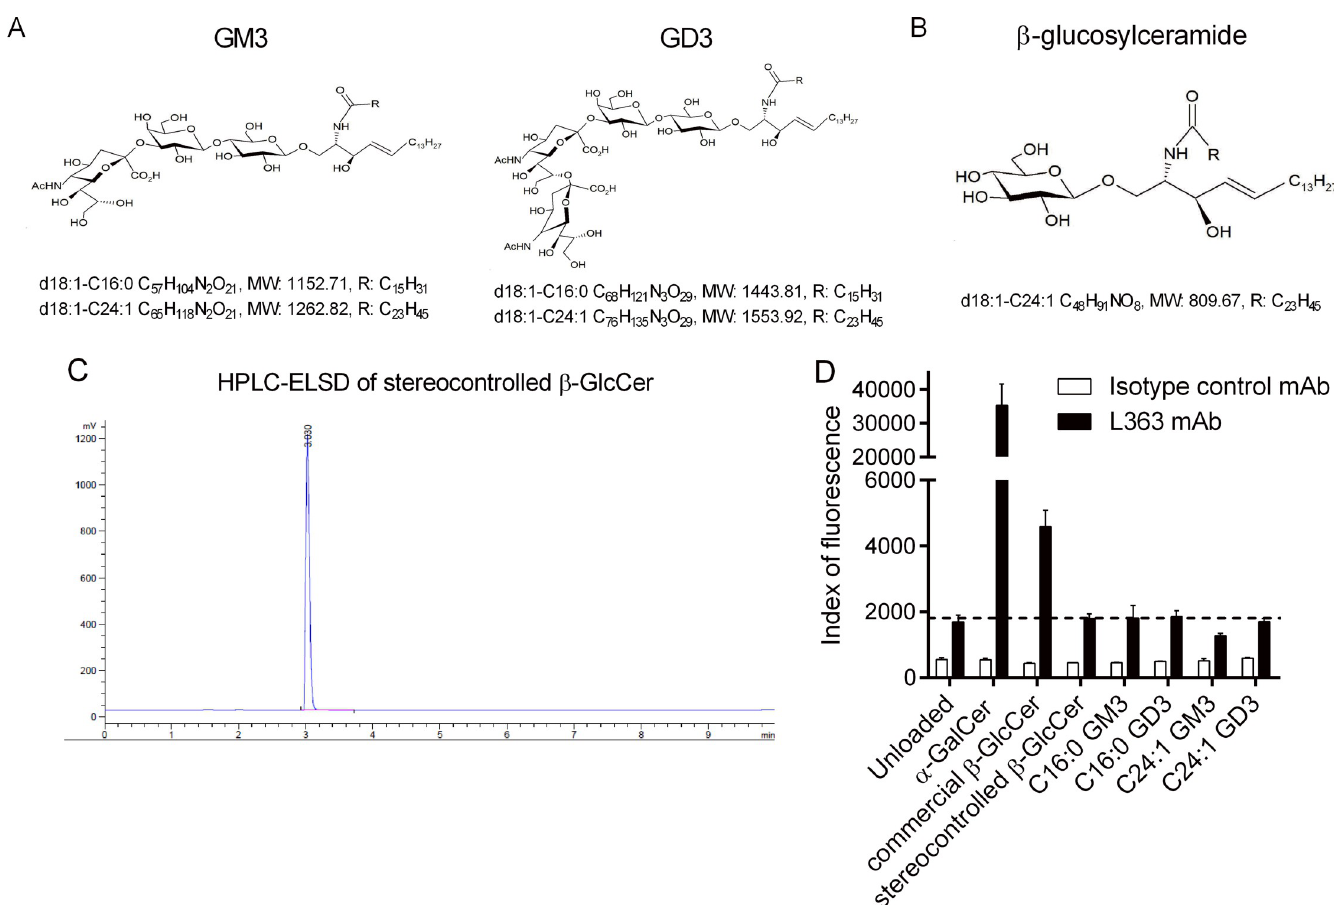
Fig 3. Structure and quality control of ganglioside species. (A) Structures and formulas of synthetic GM3 and GD3 gangliosides. (B) Structure and formula of synthetic β -glucosylceramide (C24:1). (C) HPLC-ELSD of stereo-controlled β -GlcCer. (D) Plate-bound CD1d dimers loaded with various glycolipids were incubated with the PE-conjugated L363 mAb. Fluorescence at 575 nm was measured using a microplate reader. One representative experiment out of two performed in triplicates is shown. Underlying data used in the generation of this figure can be found in S1 Data. β -GlcCer, β -glucosylceramide; CD1d, cluster of differentiation 1d; HPLC-ELSD, high-performance liquid chromatography-evaporative light scattering detector; mAb, monoclonal antibody; PE, phycoerythrin.